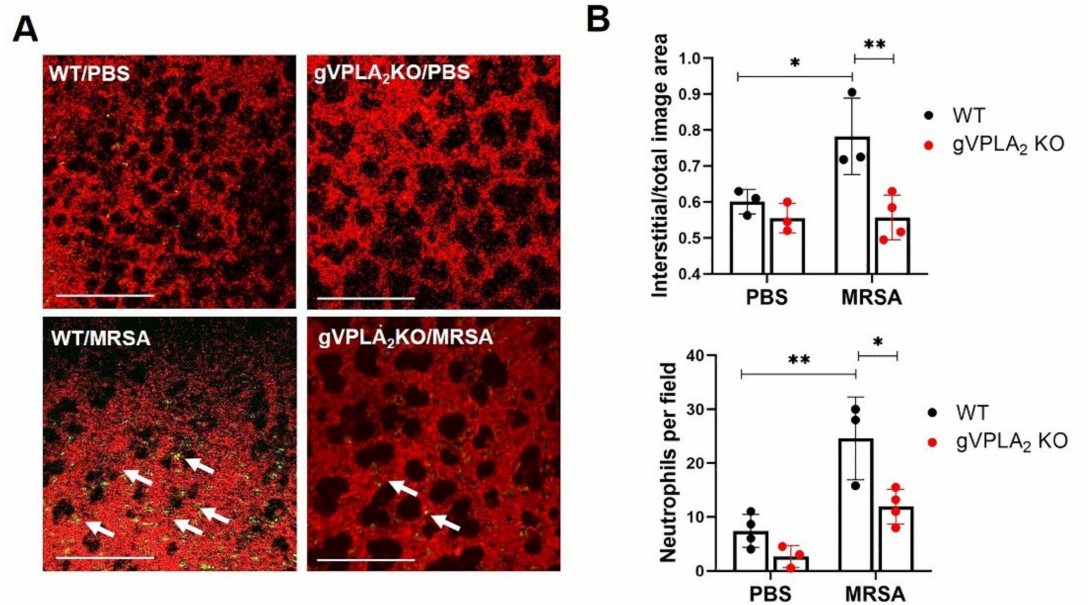
Figure 7. Lung intravital microscopy of gVPLA 2 KO and WT mice challenged with HK-MRSA. C57BL/6 WT and gVPLA 2 knockout (gVPLA 2 KO) mice were challenged with HK-MRSA-USA300 (2 × 10 8 CFU/mouse, IT) or PBS and imaged by intravital microscopy 18 h later. ( A ): Representative images show the lung interstitial area labeled with TMR-dextran (red) and fluorescent-labeled neutrophils (green), also indicated by white arrows. Scale bar: 200 µ m. ( B ): Quantification of the interstitial area and neutrophil accumulation. * p < 0.05 ** p < 0.01. n = 3–4